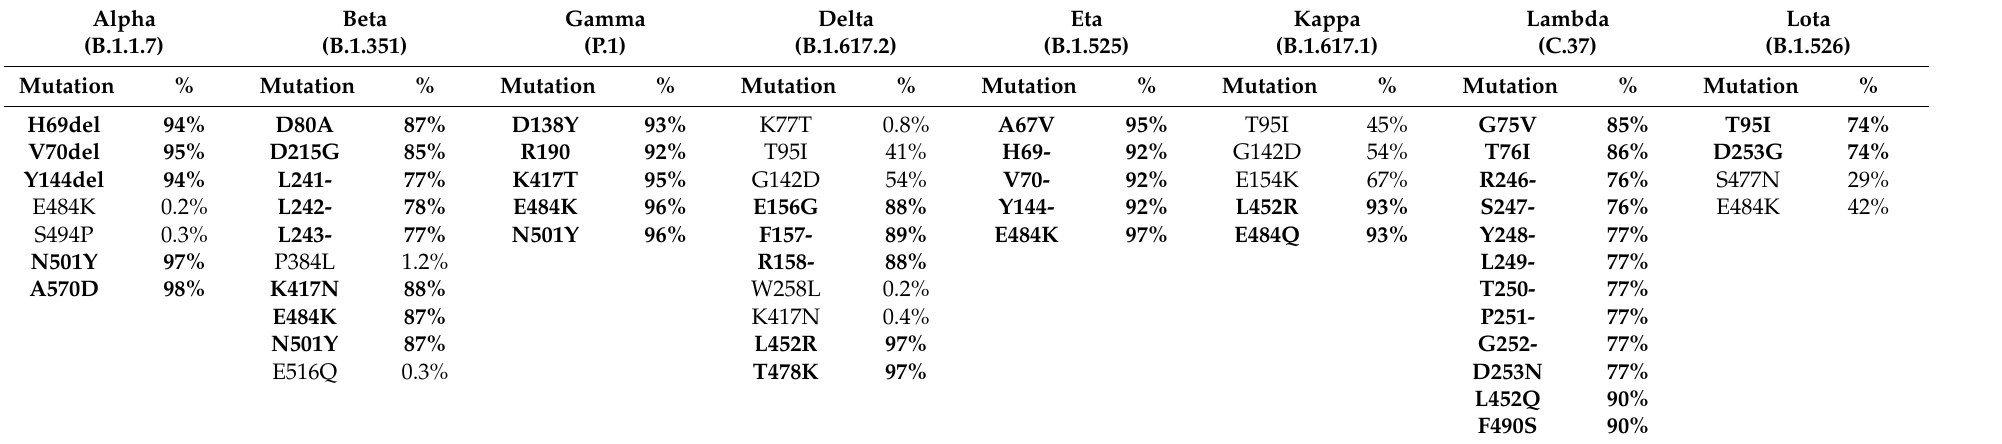
Table 1. Mutations detectable by sequencing of the PCR assay amplicon.